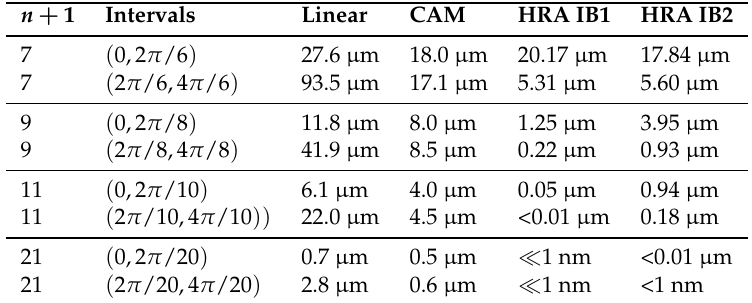
Table 3. Maximum interpolating errors for a curve generated based on a set of points p 1 , . . . , p n + 1 in the first and second non-data intervals, for different interpolation